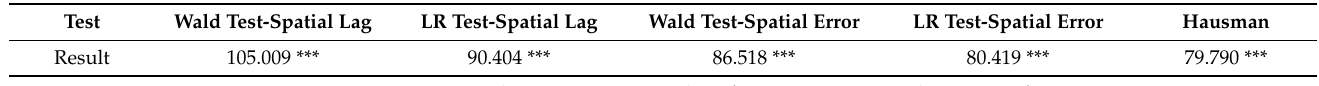
Table 4. Results of the Wald, likelihood ratio (LR), and Hausman